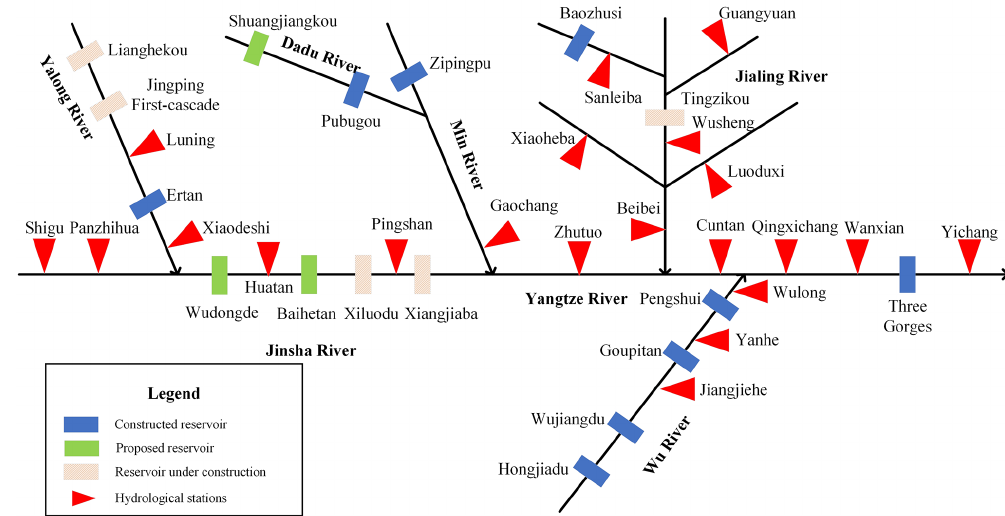
Figure 1. Diagram of Main Reservoirs on the Upper Yangtze